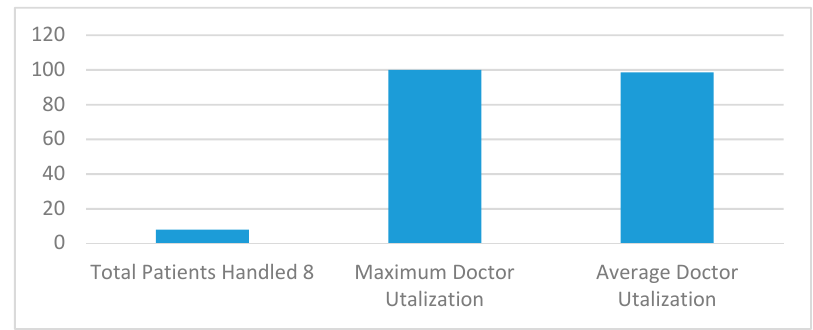
Figure 34. AnyLogic Graph for Patients and Doctor Statistics.